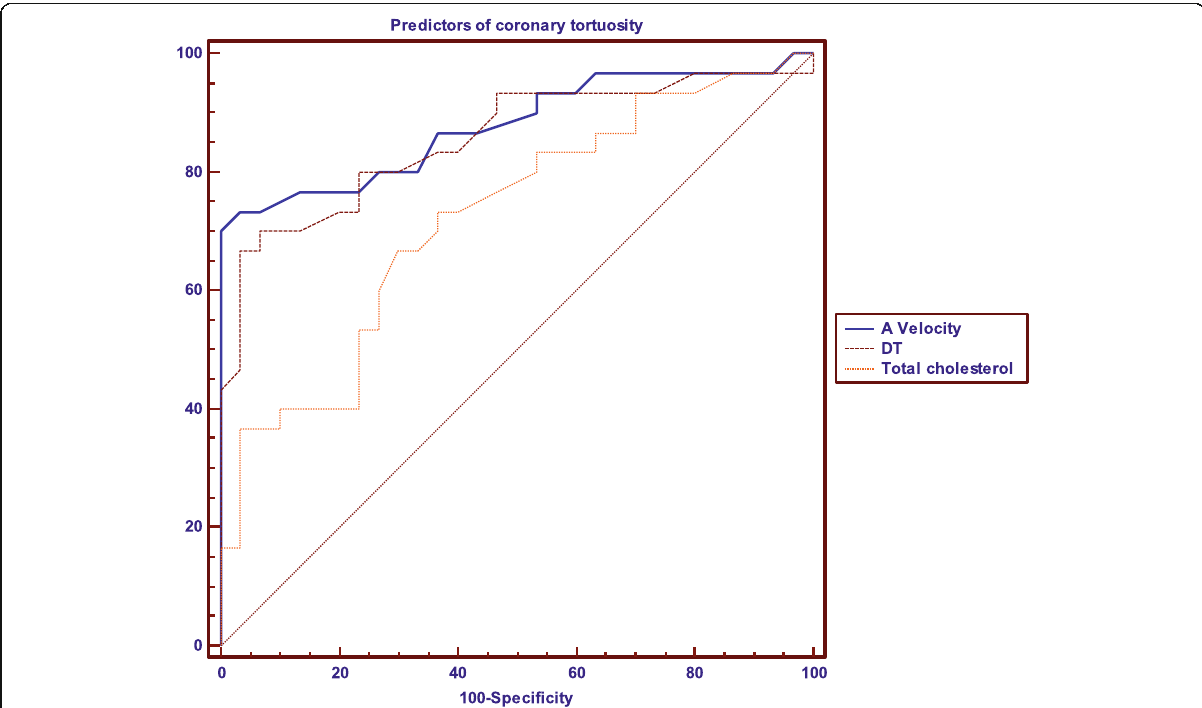
Fig. 6 ROC analysis of the most significant predictors of coronary tortuosity. A wave velocity had the highest area under the curve, followed by DT and total cholesterol. DT deceleration time